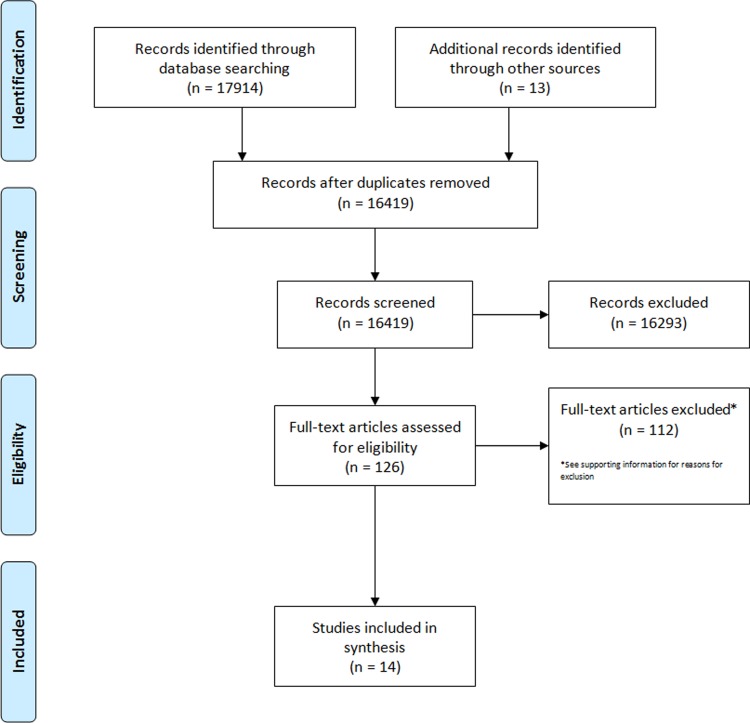
PRISMA flow diagram.